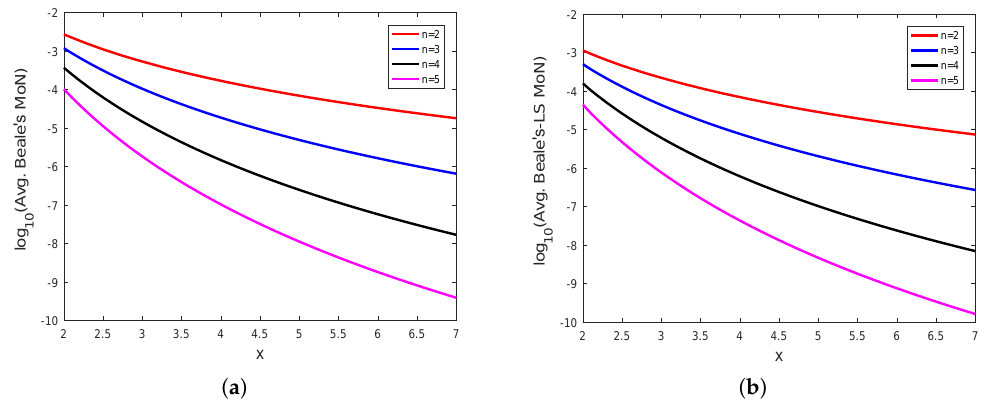
Figure 8. ( a ) Logarithm of Beale’s MoN (log (Avg. Beale’s MoN)) vs. x and ( b ) logarithm of Beale’s 10 MoN using LS (log (Avg. Beale’s-LS MoN)) vs. x with 10 scalar measurements. 10